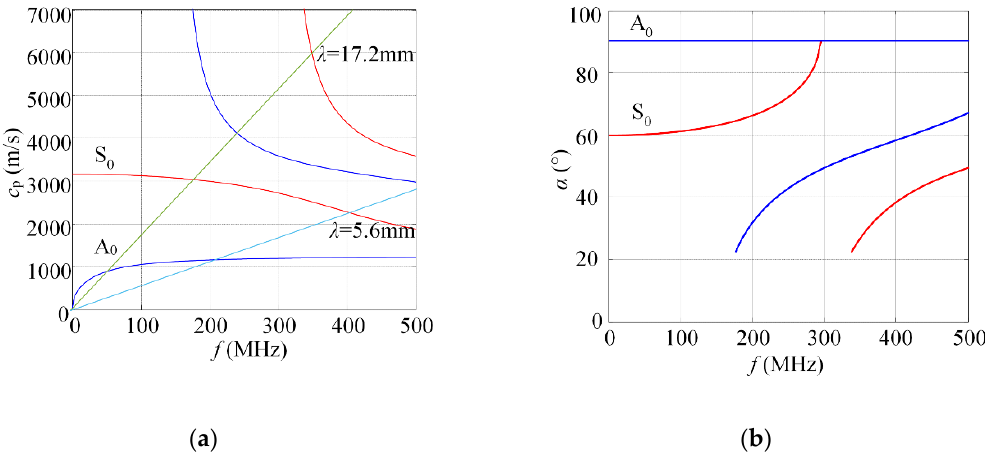
Figure 2. Phase velocity dispersion curves of 4 mm glass fibre reinforced plastic (GFRP) plate ( a ) and excitation angle versus frequency using Plexiglas as coupling medium ( b ).